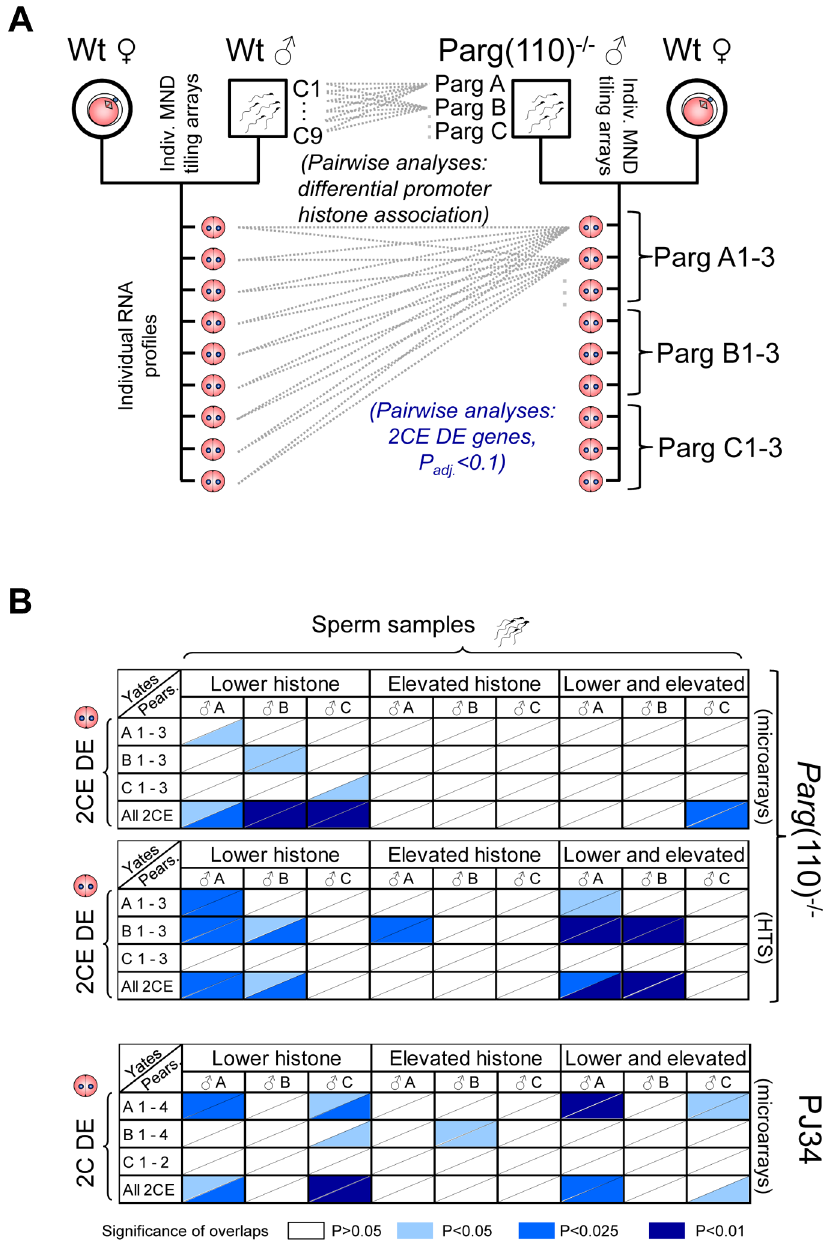
Figure 4. Differential sperm histone association of genes in Parg (110) 2 / 2 and PJ34-treated males is significantly associated with differential expression of these genes in offspring 2-cell embryos. (A) Outline of the comparison procedure, shown here only for the Parg (110) gene disrupted mouse model. A similar regimen was used for the PJ34-treated males and their offspring. Differential histone association of genes in sperm from individual males (PargA, PargB, PargC) was determined by pair-wise comparison with all individual wild-type data sets obtained from 9 individually analyzed control males. Differential gene expression was determined by pair-wise comparison of individual offspring from the Parg (110) 2 / 2 males (PargA1-PargC3) with all 9 individual wild-type 2-cell embryo data sets by either microarrays or next generation sequencing. Differential gene expression was determined using ANOVA analyses and adjusted P-value calculation (with P adj , 0.1 considered to be significant). (B) Pearson (uncorrected) and Yates (corrected) Chi-squared tests were used to determine the significance of overlaps of the lists of genes that were differentially histone associated in sperm samples of the sires (‘‘Sperm samples’’) compared to controls (Parg A–C and PJ34A–C), with the lists of genes that were differentially expressed in at least one of the 3 or 4 offspring 2-cell embryos from these sires (‘‘2CE DE’’, Parg (110) 2 / 2 : A 1–3, B 1–3, C 1–3, and for PJ34: A1–4, B1–4, C1–2). A genetic background of 19,472 genes interrogated by the microarrays and 20,018 genes interrogated by the tiling arrays and sequencing platforms was used for the calculations. Ranges of P-values resulting from Yates or Pearson are indicated in different shades of blue if P # 0.05, i.e., the overlaps were significant (see color legend in figure). The P-value denotes the confidence with which the null- hypothesis can be dismissed that the overlap between the list of genes with abnormal histone association in the sire with the list of genes that are DE in the offspring could be predicted by statistical probability, i.e. coincidence. Upper two panels: Parg (110) 2 / 2 group of fathers and offspring embryos, microarray expression analyses with either Yates’ chi-squared test (upper triangular portion of each cell) or Pearson’s (lower triangular portion of cells). HTS: Parg (110) group, high throughput sequencing of 2CE gene expression. Lower panel: overlaps of PJ34-treated group of fathers (sperm) and offspring embryos (2-cell embryo differential gene expression, ‘‘2CE DE’’). Note that mainly overlaps between genes with lower histone retention in sperm and differentially expressed genes in offspring embryos are significant with P # 0.05 (left 1/3 portion of each panel). doi:10.1371/journal.pgen.1004317.g004 PLOS Genetics |